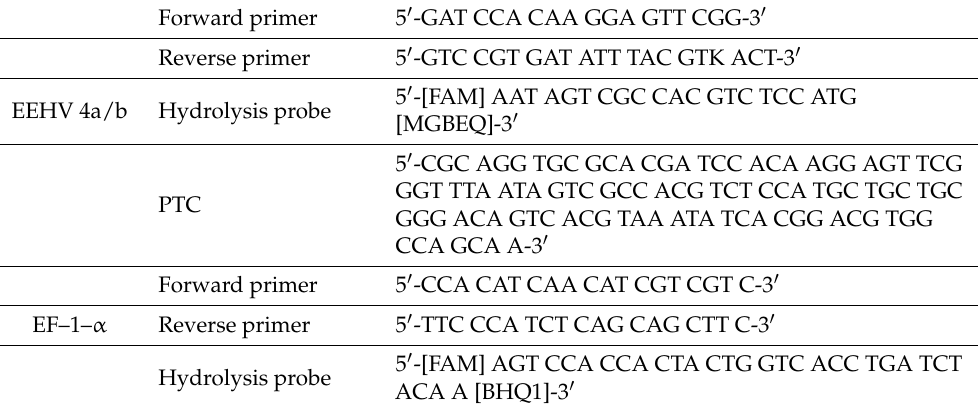
Table 1. Primers, hydrolysis probes and PTCs employed to detect EEHV 4a/b [46], and EF–1– α . EEHV 1a/b primers and probes were from Stanton et al. (2010)